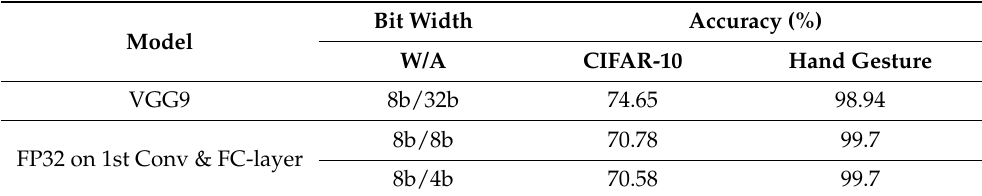
Table 4. Quantization comparison results between